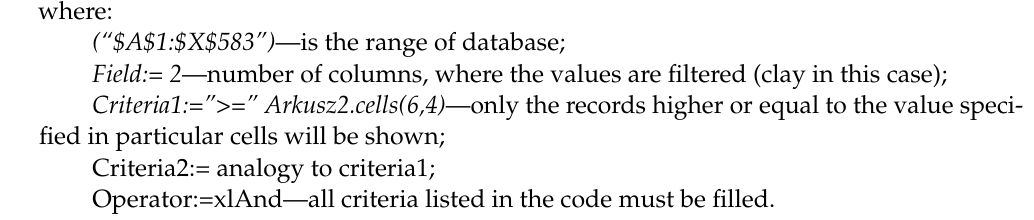
Figure 12. Example of Excel formula used after naming the ranges and using